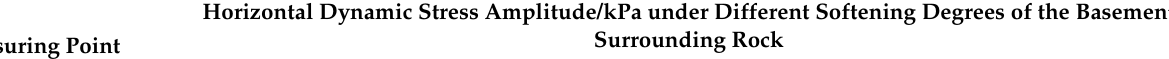
Table 10. Horizontal dynamic stress amplitudes of measuring points 2, 3, and 4 under different softening degrees of the basement surrounding rock.